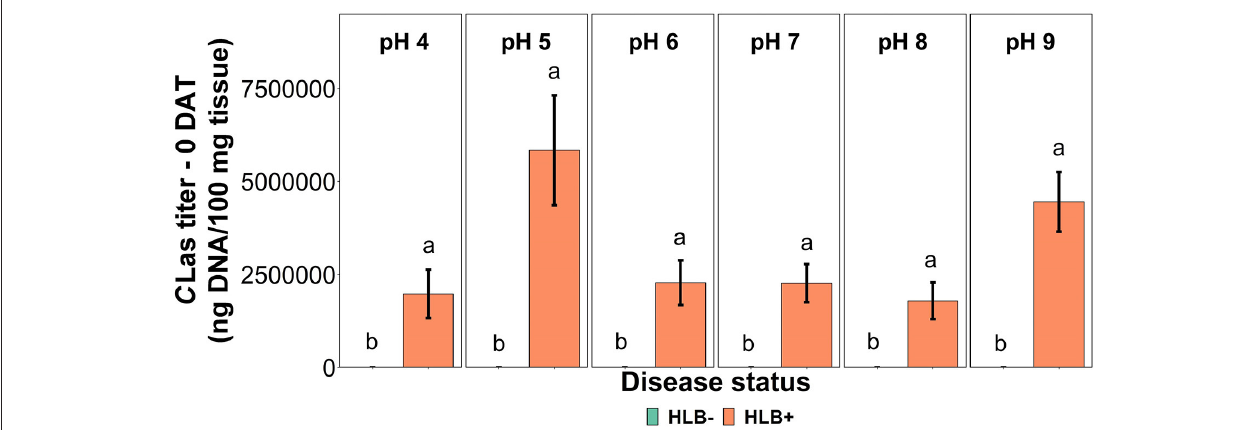
FIGURE 2 | C Las titer in “Ray Ruby” grapefruit ( C. paradisi ) on sour orange ( C. aurantium ) rootstock exposed to different HLB disease statuses [HLB-free or healthy (negative, HLB–) and HLB-affected (positive, HLB + )] under an increasing range of substrate pHs (4–9) at 0 DAT. Means ± standard error ( n = 4) followed by the same letters are not different by SNK test ( α = 0.05) within each substrate pH for different disease status.